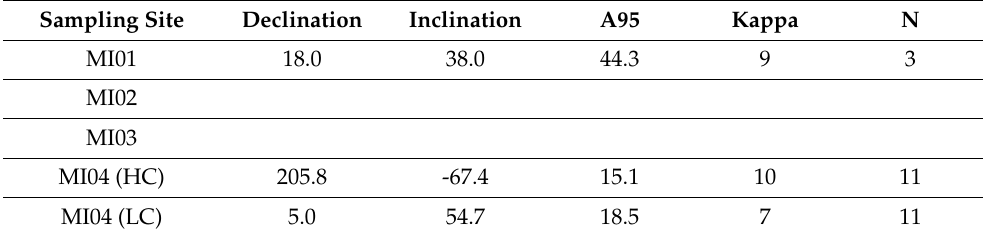
Table 6. Paleomagnetic data. Declination/inclination: mean characteristic remanent magnetization direction; A95: radius of cone of 95% confidence; kappa: Fisher dispersion parameter around the mean; N: number of samples used in statistics; HC/LC: high/low coercivity component of magnetization. Sites MI02 and MI03 did not provide any